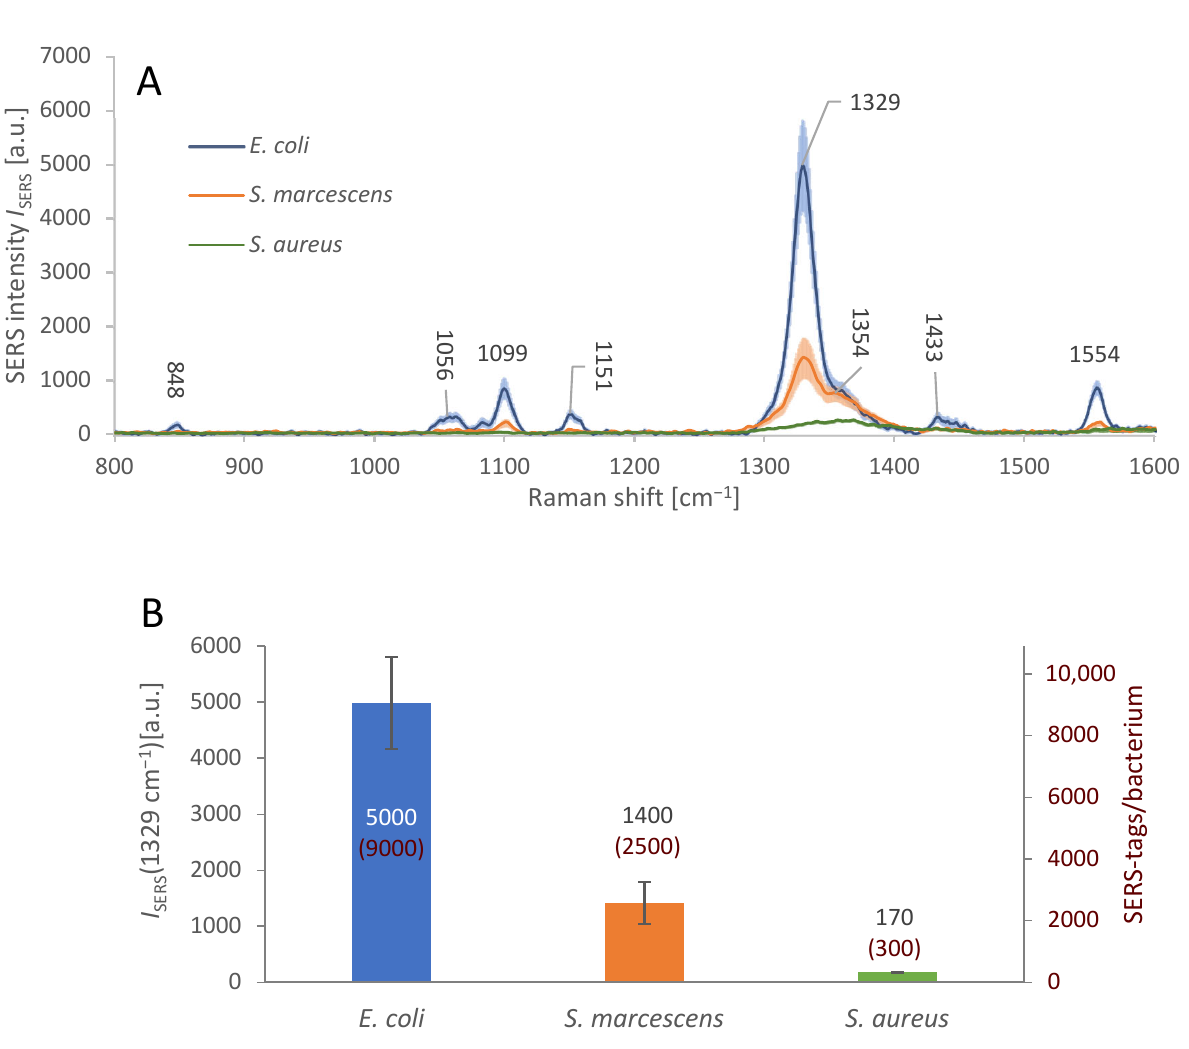
Figure 5. Sandwich immunoassay SERS signal intensity and specificity. ( A ): Average SERS spectra from individual cells of different bacterial species (see legend), in the E. coli -specific sandwich complex. E. coli cells were covered with the SERS-tags and detected by the strong SERS signal of DTNB. In case of S. marcescens and S. aureus , the signal is weaker, indicating relatively low level of undesirable non-specific interactions between these bacteria and the SERS-tags. The nominal SERS signal intensities are presented in the bar graph below. The shaded areas represent the 95% confidence interval. Microscope objective: 50 × . ( B ): Average SERS signal intensity maxima at 1329 cm − 1 , from the bacteria subjected to sandwich immunoassay, i.e., immobilization on the gold- plated glass covered in antibodies and to the detection process involving SERS-tags. The positive, specific signal of E. coli is more than 3.5 × stronger than the non-specific signal of the S. marcescens and over 28 × stronger than that of S. aureus . The numbers in red show the calculated amounts of the individual SERS-tags per bacterium. The error bars represent the 95% confidence interval of I SERS